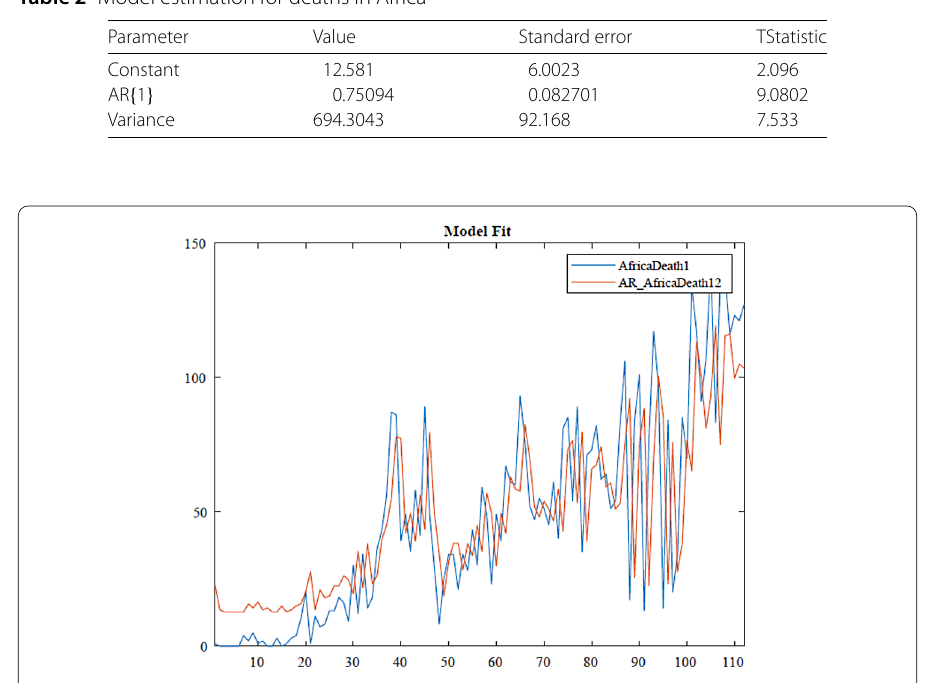
Figure 4 AR model for deaths in Africa